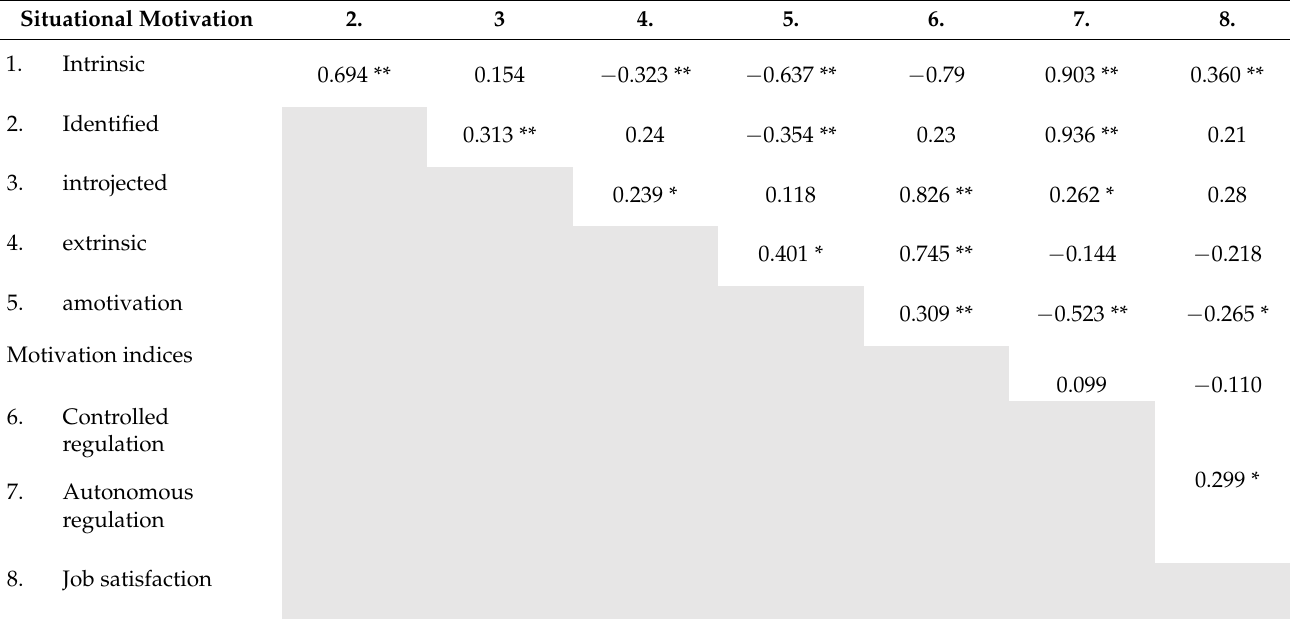
Table 3. Zero-order correlations among study